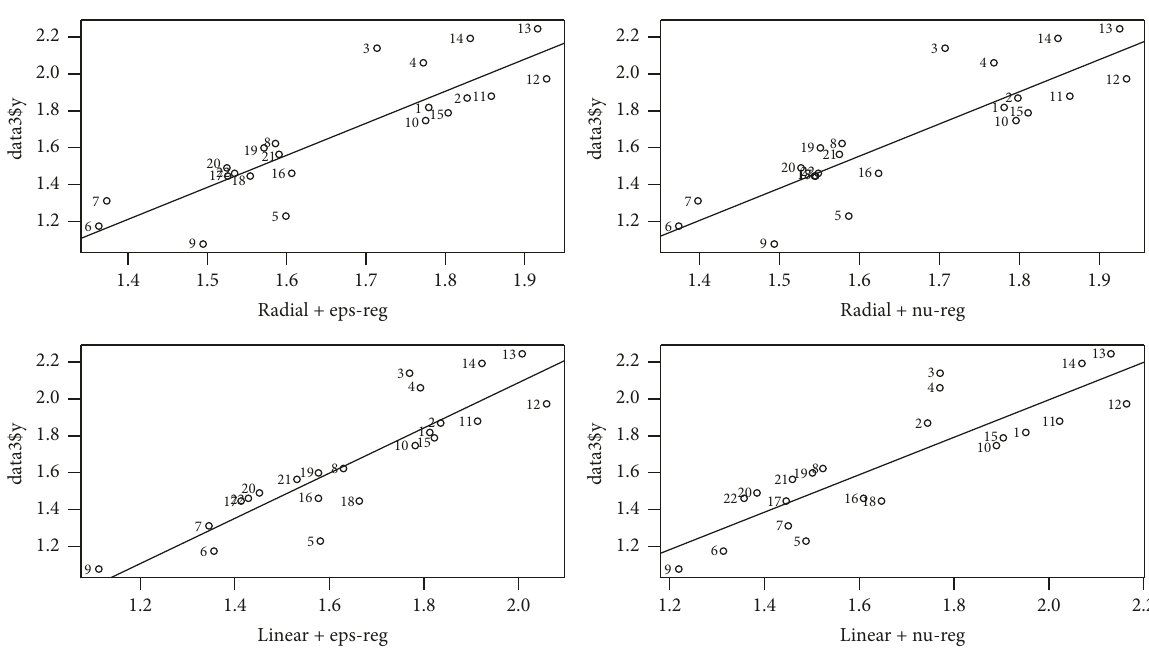
Figure 1: Scatter plot of experimental values and 4 SVM models’ internal prediction results of lgt1/2. Note . The horizontal coordinates, respectively, represent the predicted values of lgt1/2 of 4 SVM models, and the longitudinal coordinates express the experimental